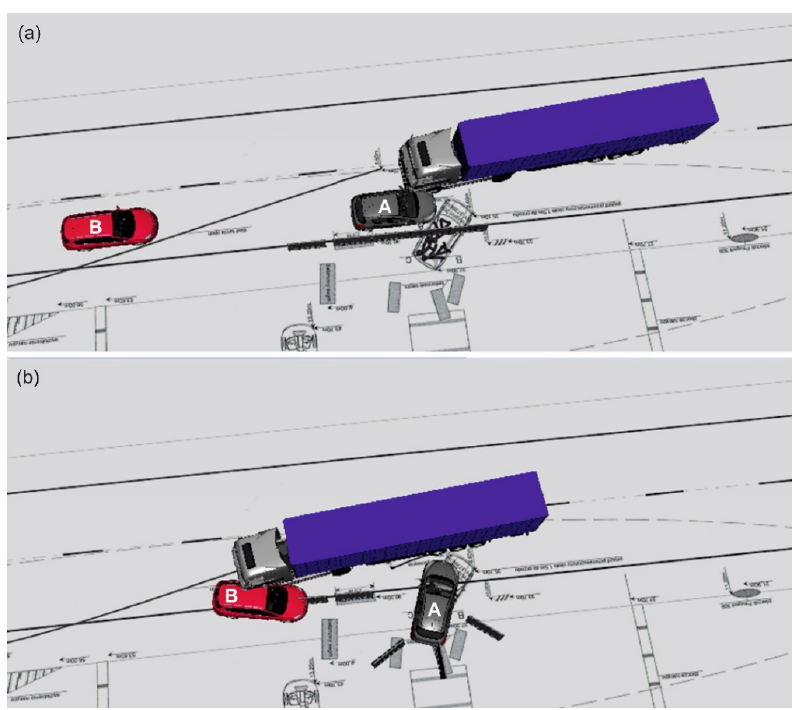
Figure 2. Location of vehicles at various stages of the accident, at the moment of ( a ) crash between Car A and Truck tractor; ( b ) collision between Car B and Truck tractor.